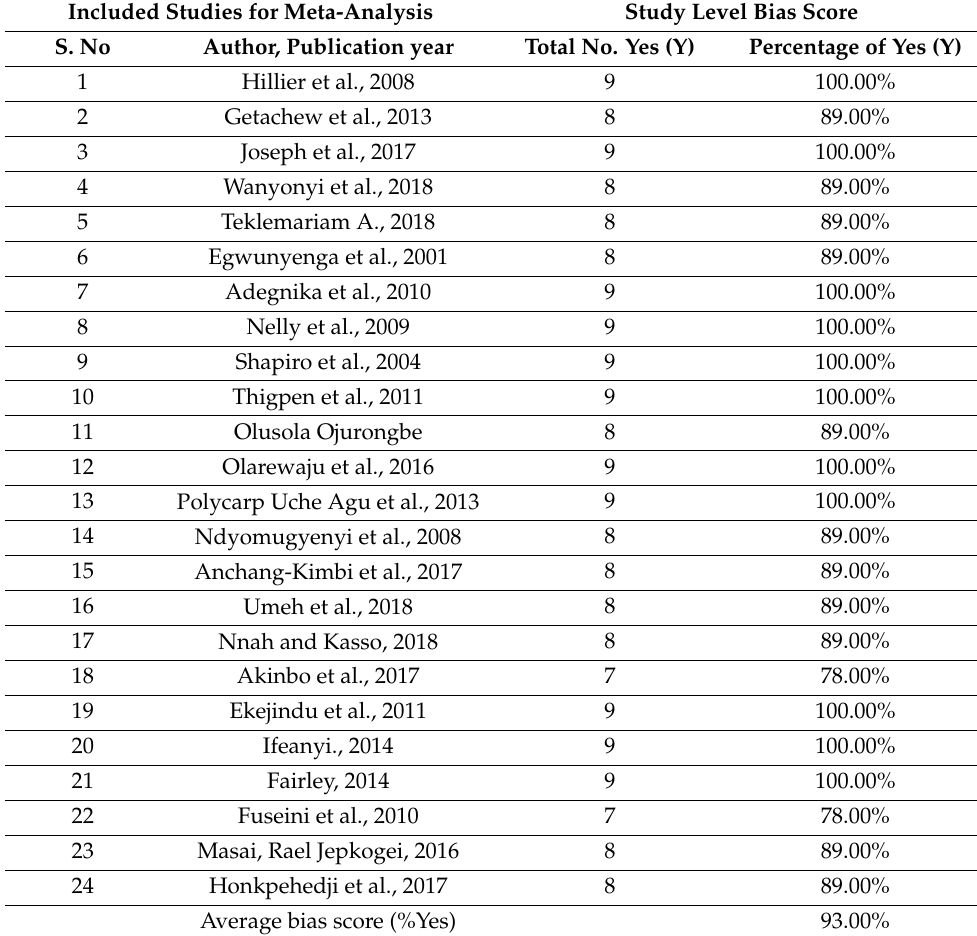
Table 1. Quality assessment of the eligible